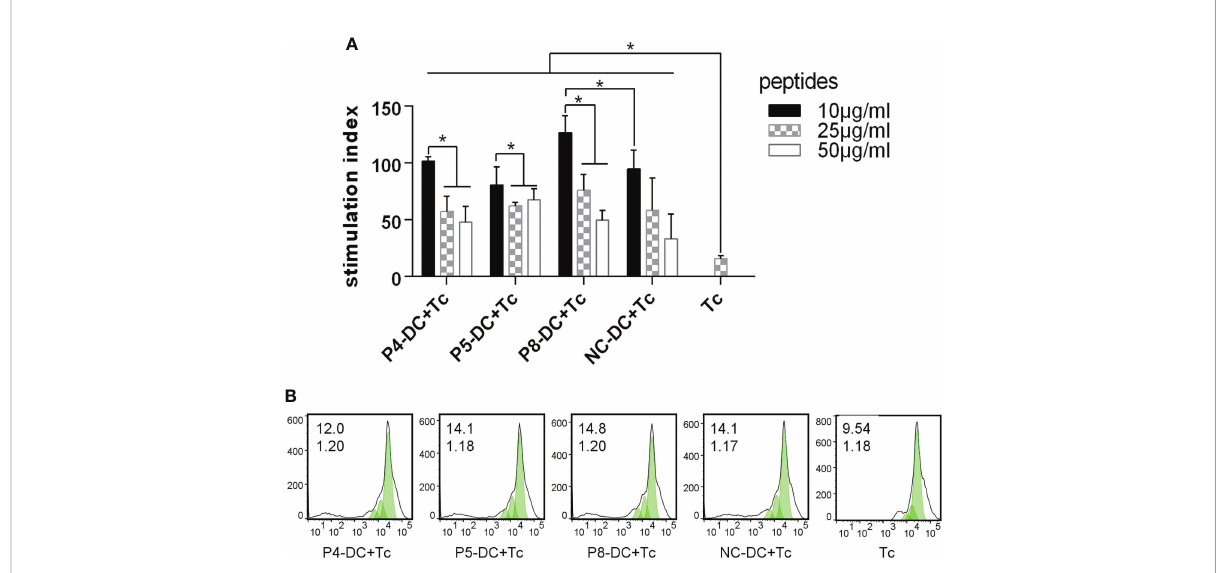
FIGURE 4 MAGE-D4 peptide-pulsed DCs stimulated the proliferation of T cells. (A) CCK8 assay. (B) CFSE assay. The value (inset) for the percentage of cells that divided at least once (top left corner) and the proliferation index (bottom left corner) are indicated for each sample. DC, dendritic cell; Tc, T cell; NC, negative control peptide. *P <0.05.